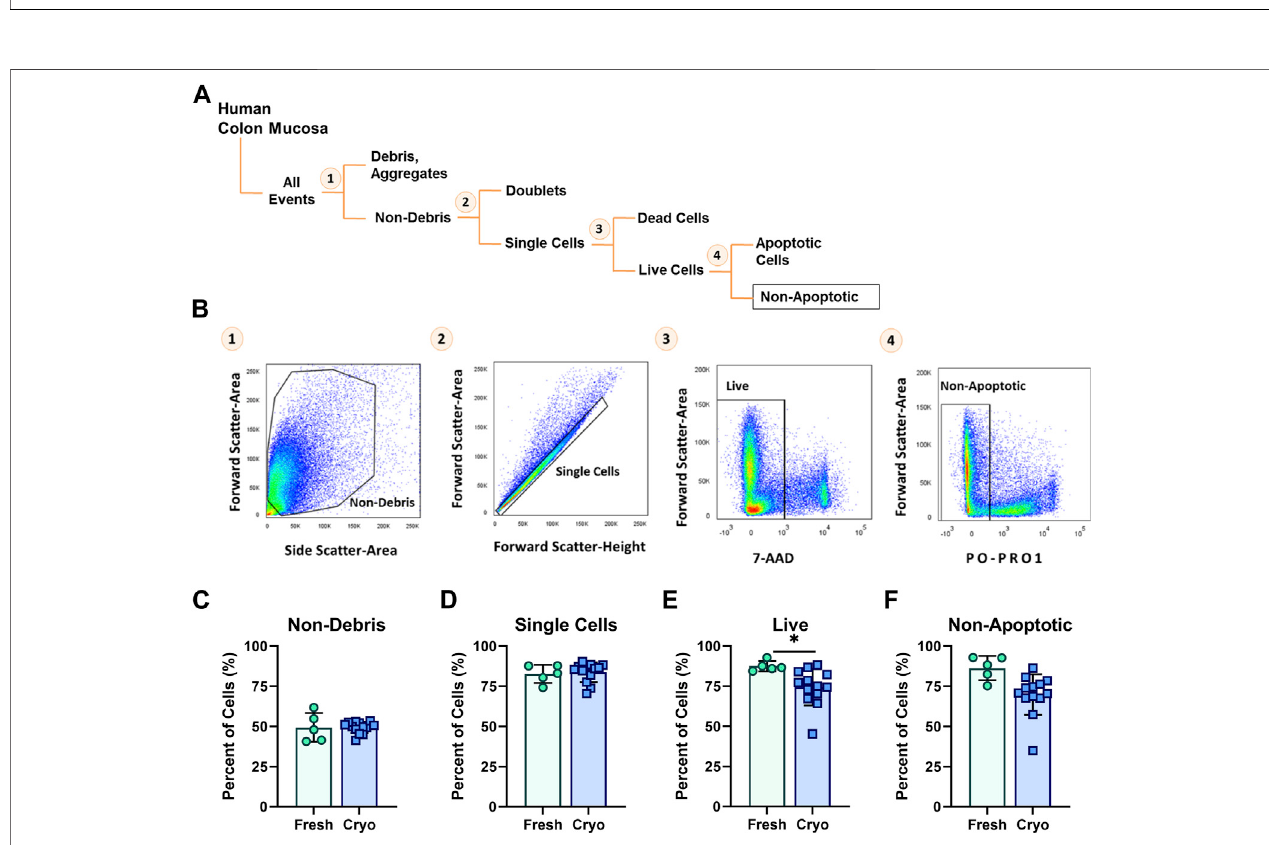
FIGURE2|(A) Diagramand (B) correspondingFACS-plotsdemonstratingthesequential fl ow-cytometricgatingstrategyusedtoisolatecells.Averagepercentage of cells obtained from fresh (green circles, n = 5) and cryopreserved (blue squares, n = 13) tissue preparations throughout the population hierarchy: (C) Non-debris, (D) singlets, (E) Liveand (F) Non-apoptoticcells,duringFACS.Eachsymbolrepresents1humanparticipant.Signi fi cancetestingusedatwo-tailedstudentt-test;* p < 0.05.